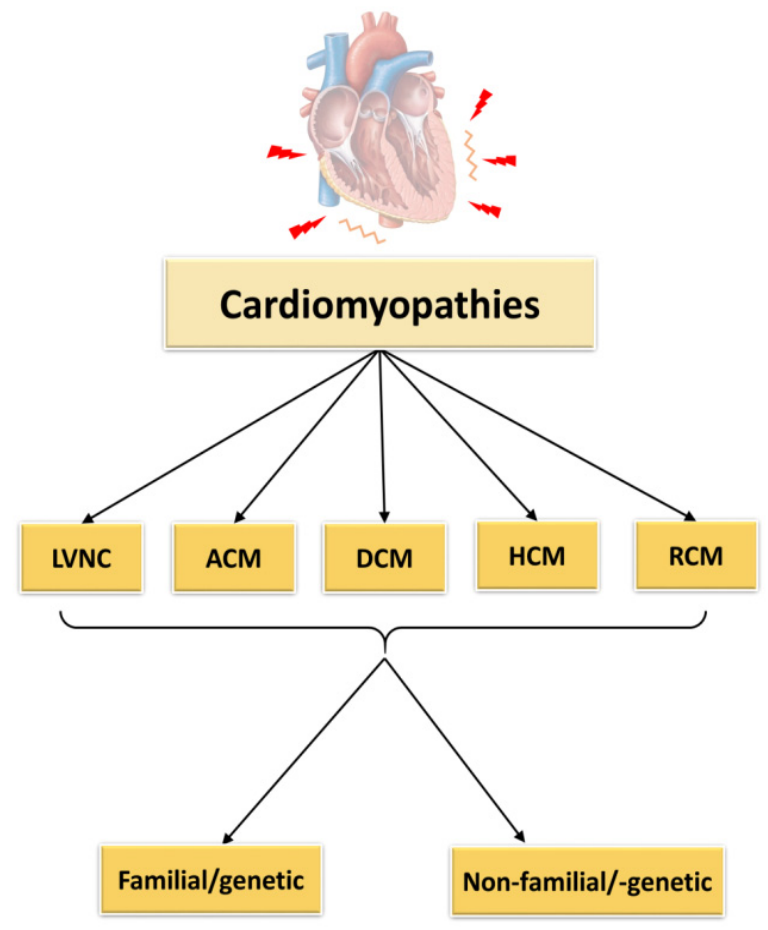
Figure 2. Classification of cardiomyopathies. LVNC = left ventricular non-compaction cardiomyopa- thy, ACM = arrhythmogenic cardiomyopathy, DCM = dilated cardiomyopathy, HCM = hypertrophic cardiomyopathy, RCM = restrictive cardiomyopathy. The figure was created using PowerPoint (Microsoft).